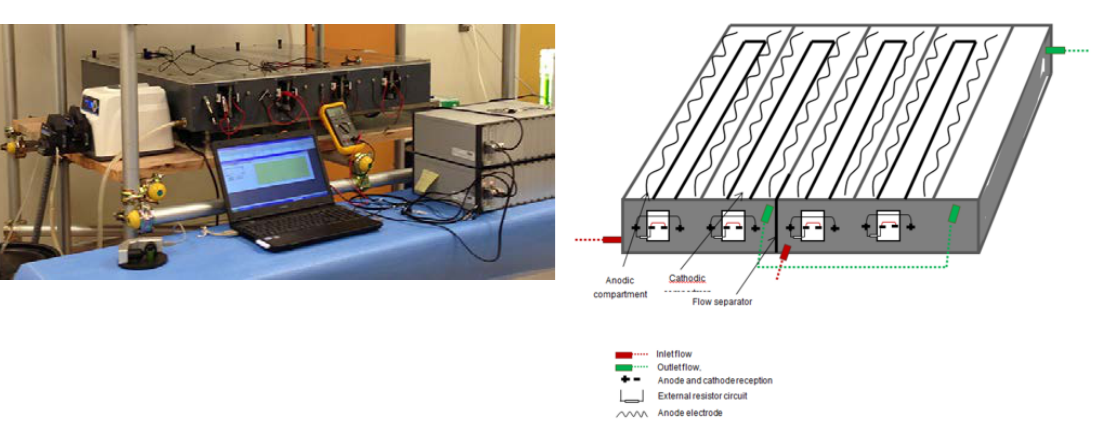
Figure 1: The awamori wastewater-fed microbial fuel cell bioreactor and associated equipment, Okinawa, Japan (left) and schematic drawing of the MFC showing fluid flow and electrical components